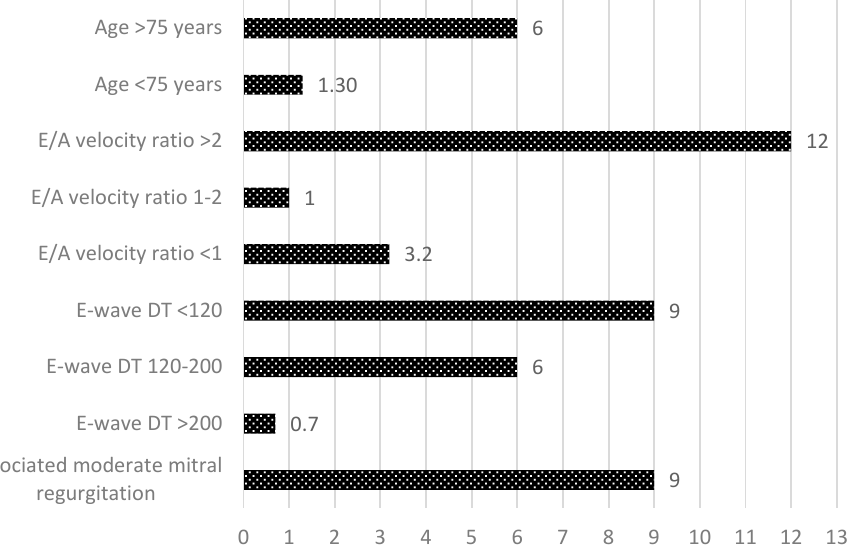
Figure 1. Relative risk for the occurrence of pulmonary hypertension in patients with aortic stenosis. The presence of severe PHT increased the early postoperative risk of death by 9.8-fold, regardless of the presence of other known parameters that increased mortality rate in these